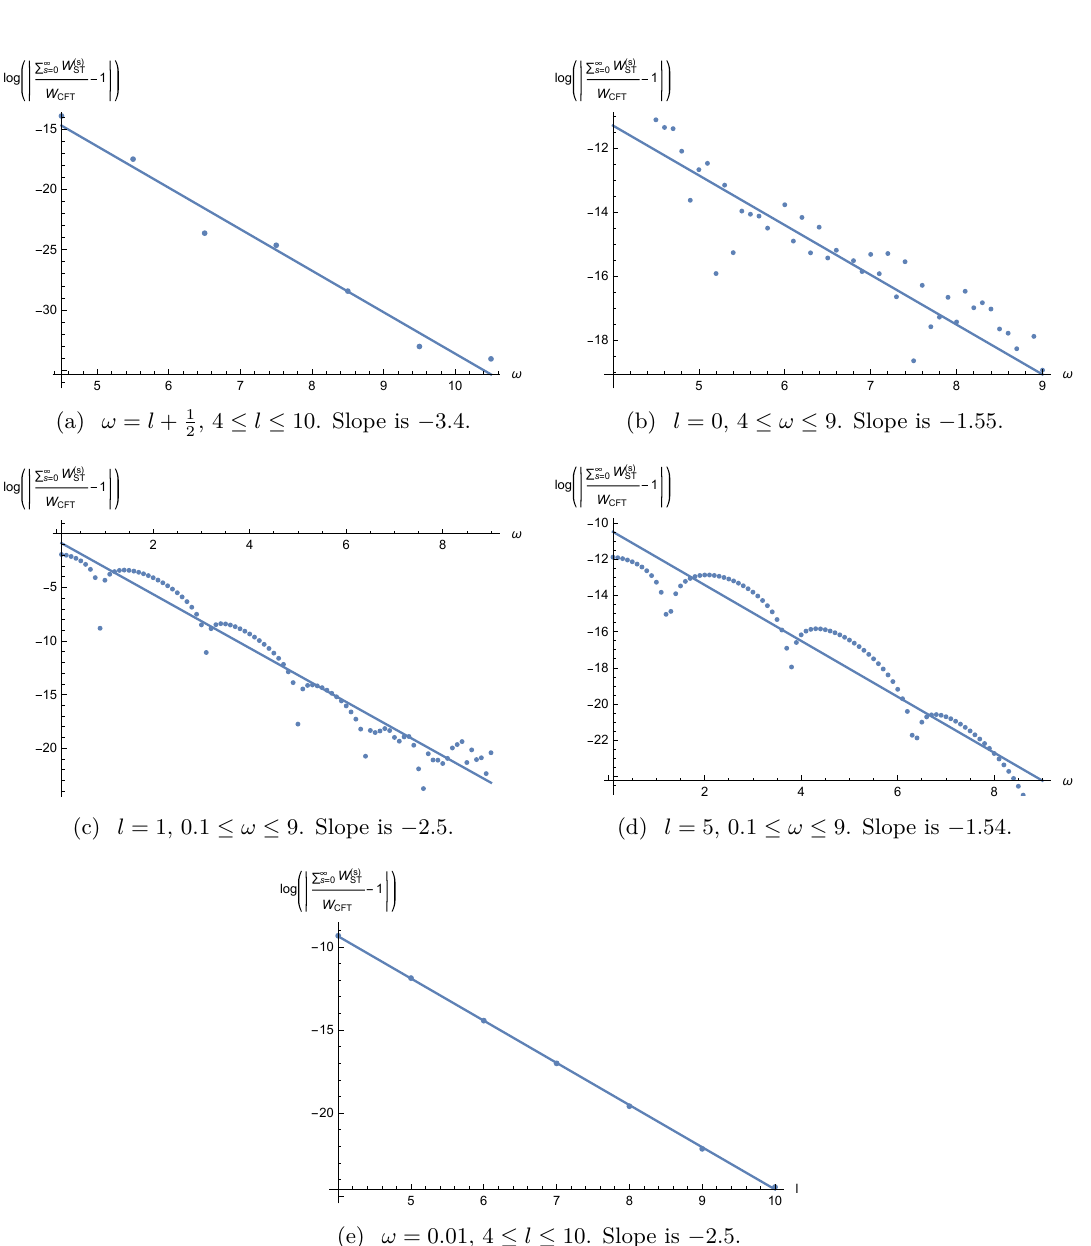
Figure 13 . Numerical log plots of the relative discrepancy between the CFT correlator and the all-spin Sleight-Taronna contributions, at large boundary frequencies ω and/or l . As expected, the discrepancy decays with frequency exponentially. This expresses the radial locality of the new bulk